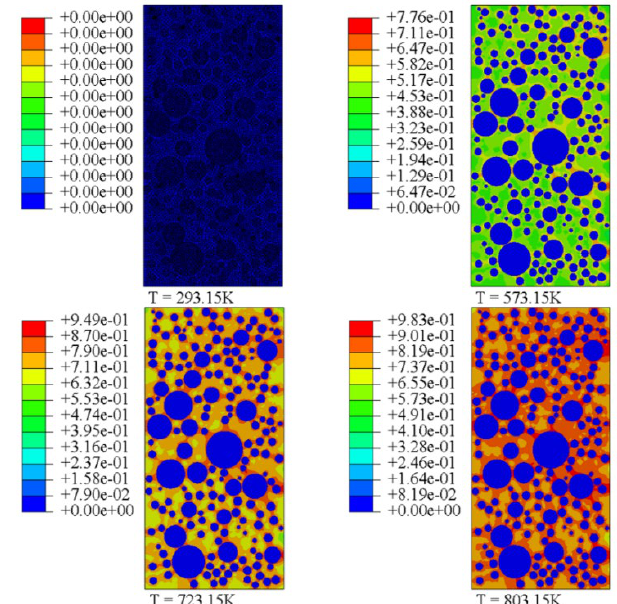
Figure 11. Damage map (adimensional) for 293.15, 573.15, 723.15 and 803.15 K.